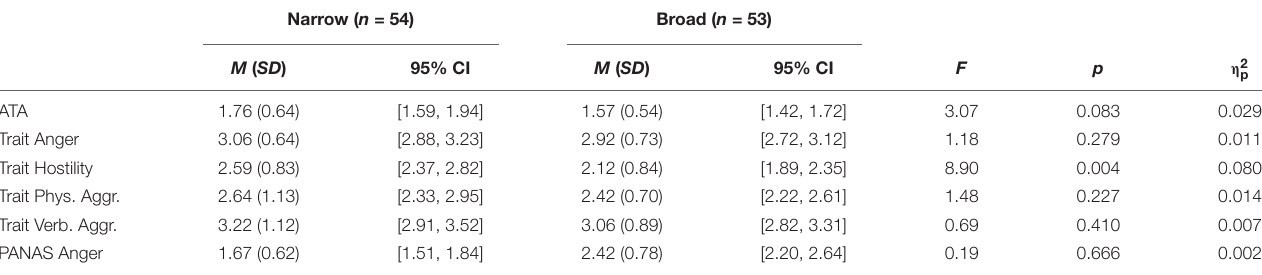
TABLE 1 | Effect of cognitive scope condition on attitude toward anger and trait aggression subscales – Study